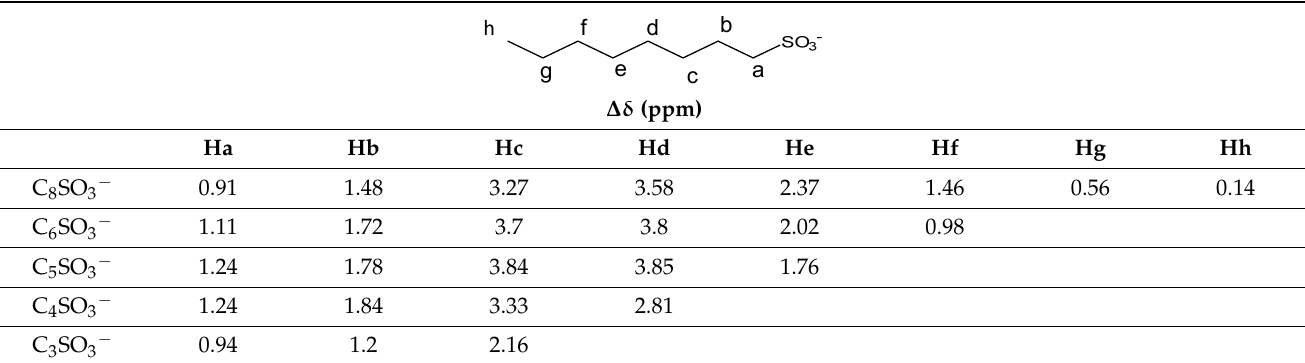
Table 1. Magnitude of the complexation induced chemical shifts (ppm) for host:guest complexes between pillararene and different alkylsulfonates.